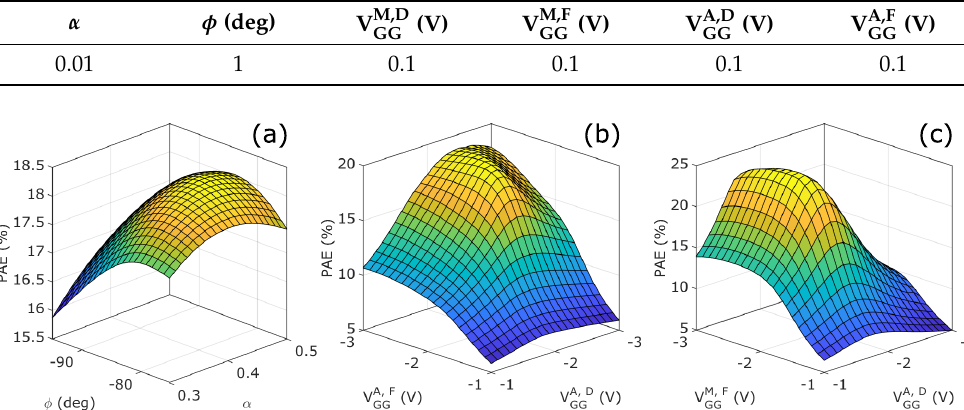
Figure 4. Example of 2D sweeps cyclically realized by the coordinate descent optimization of PAE for the DIDPA under study versus ( a ) input splitter parameters ( α , φ ), ( b ) auxiliary amplifier bias voltages ( V A , D , V A , F ), and ( c ) main amplifier bias voltages ( V M , D GG GG